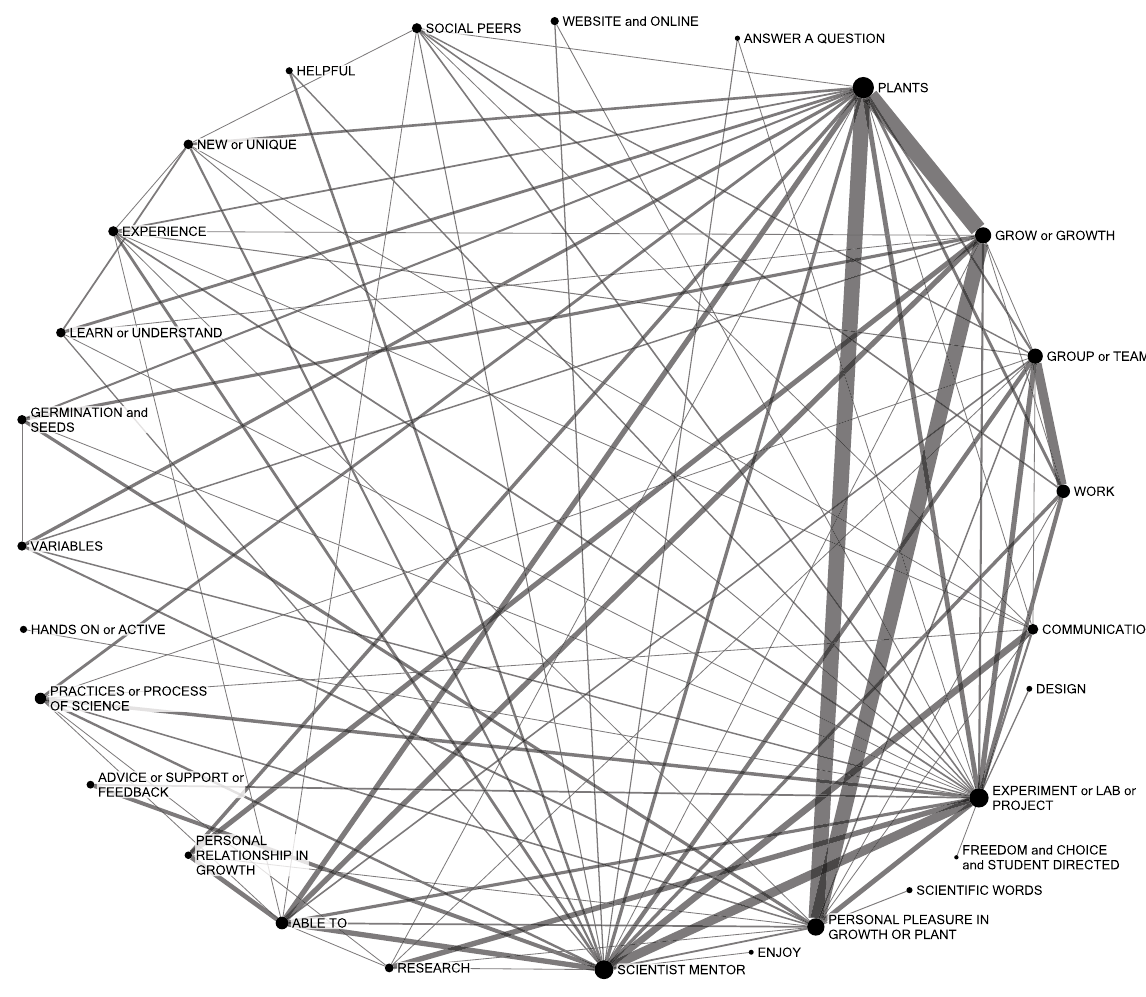
Figure 1. Lexical web illustrating the four themes that students liked most and connections among favored elements. The size of the node represents the number of total respondents liking that element, and the width of the line between nodes is weighted by the number of shared responses. Items with fewer than 20 respondents are filtered out to simplify the lexical web. The size of the nodes corresponds to the number of responses in a given category, while the thickness of the lines represents the number of links between